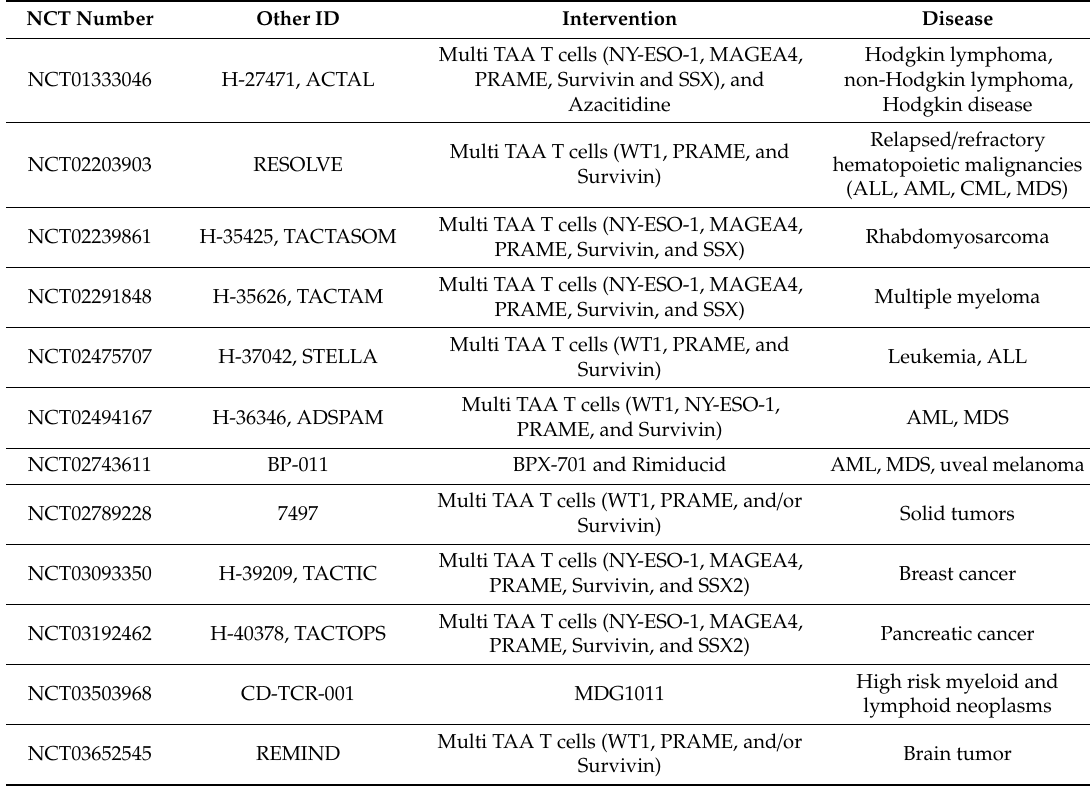
Table 1. Ongoing clinical trials of cellular PRAME